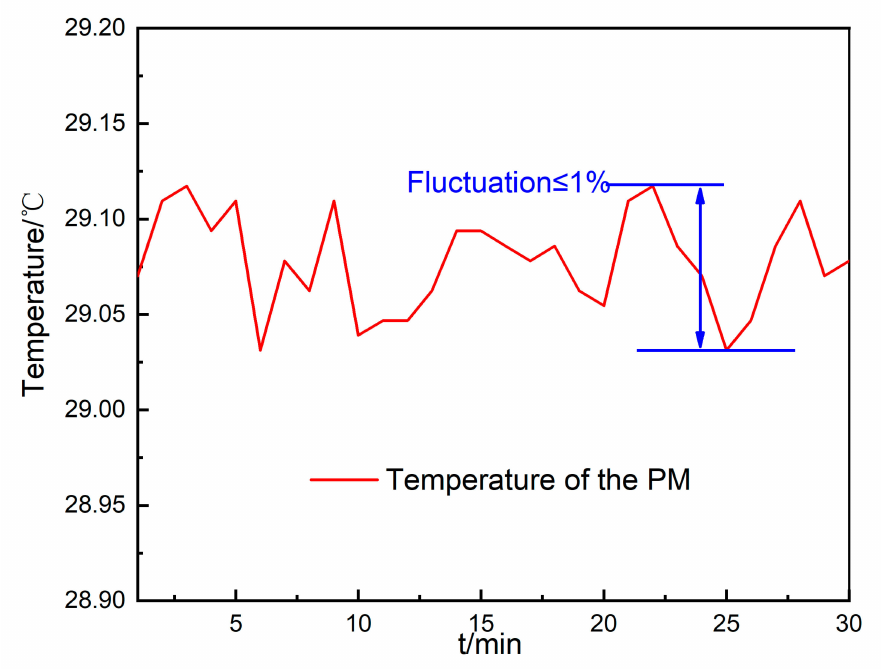
Figure 15. Temperature variation of the PM within 30 min ( s = 25 r / min).